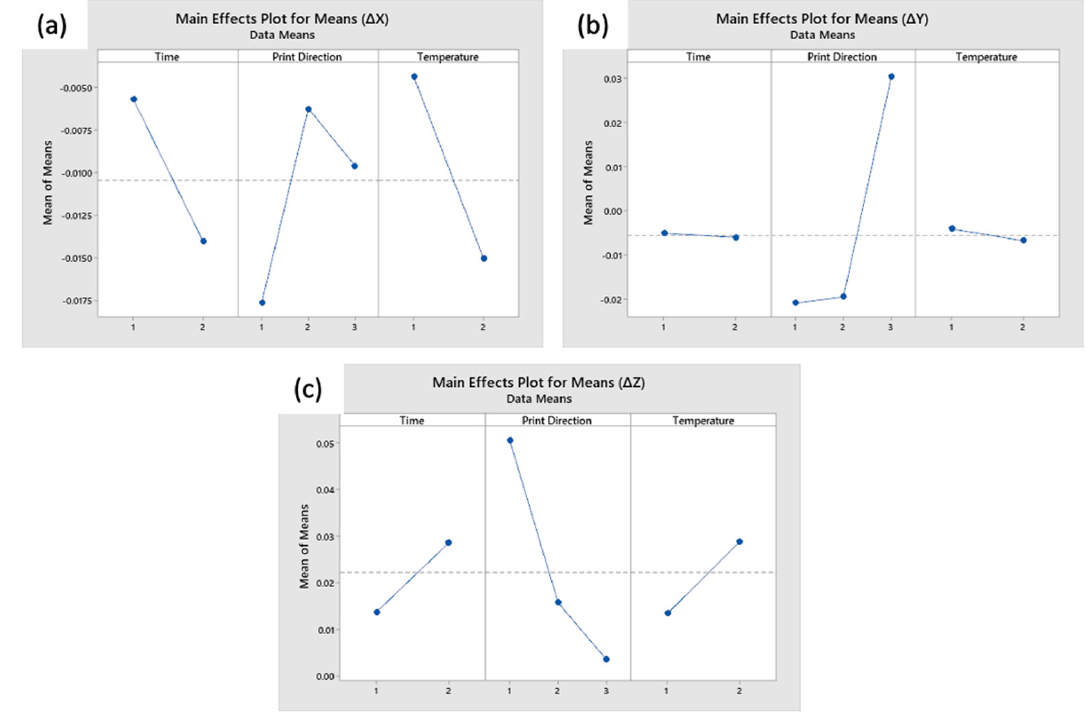
Figure 6. Effect plot for change in dimensions in the ( a ) X direction, ( b ) Y direction, and ( c ) Z direc-